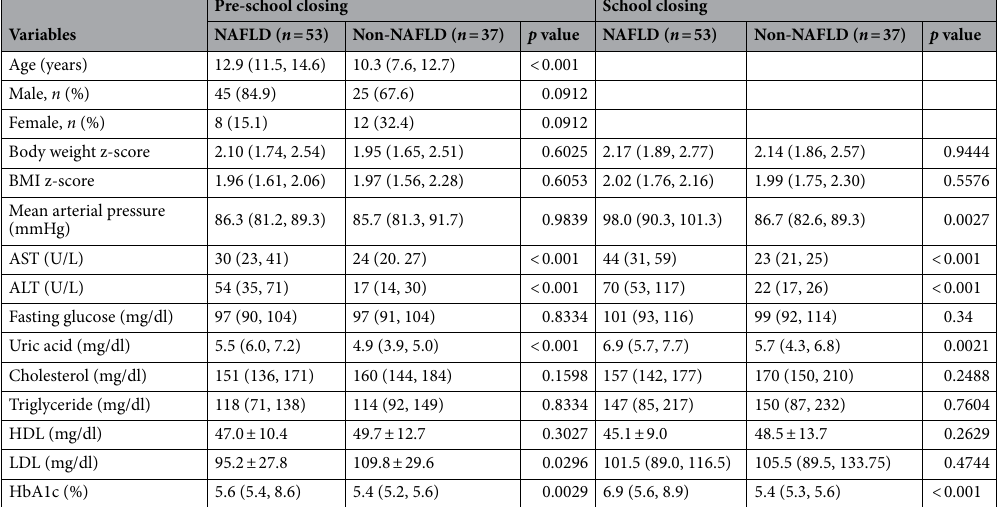
Table 3. Comparison of variables according to the presence of NAFLD between pre-school closing and during school closing period. BMI body mass index, NAFLD non-alcoholic fatty liver disease, AST aspartate